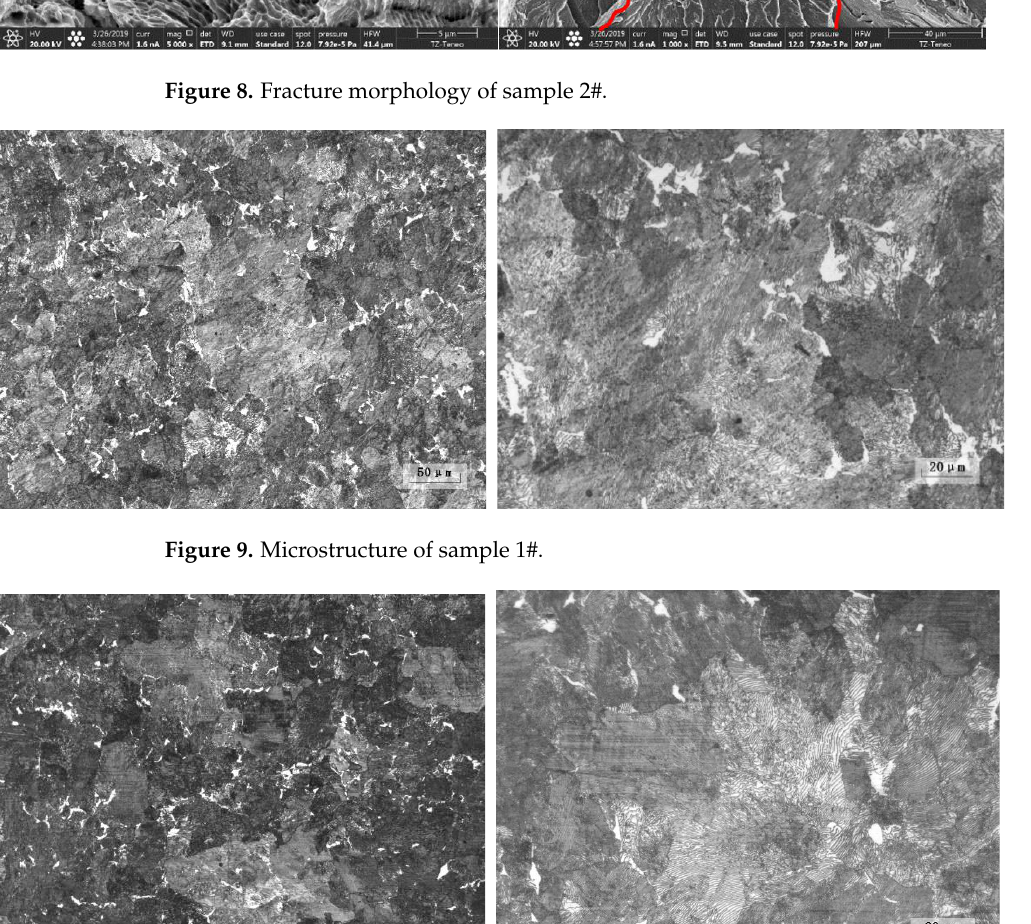
Figure 10. Microstructure of sample 2#. Table 5. OM test results.